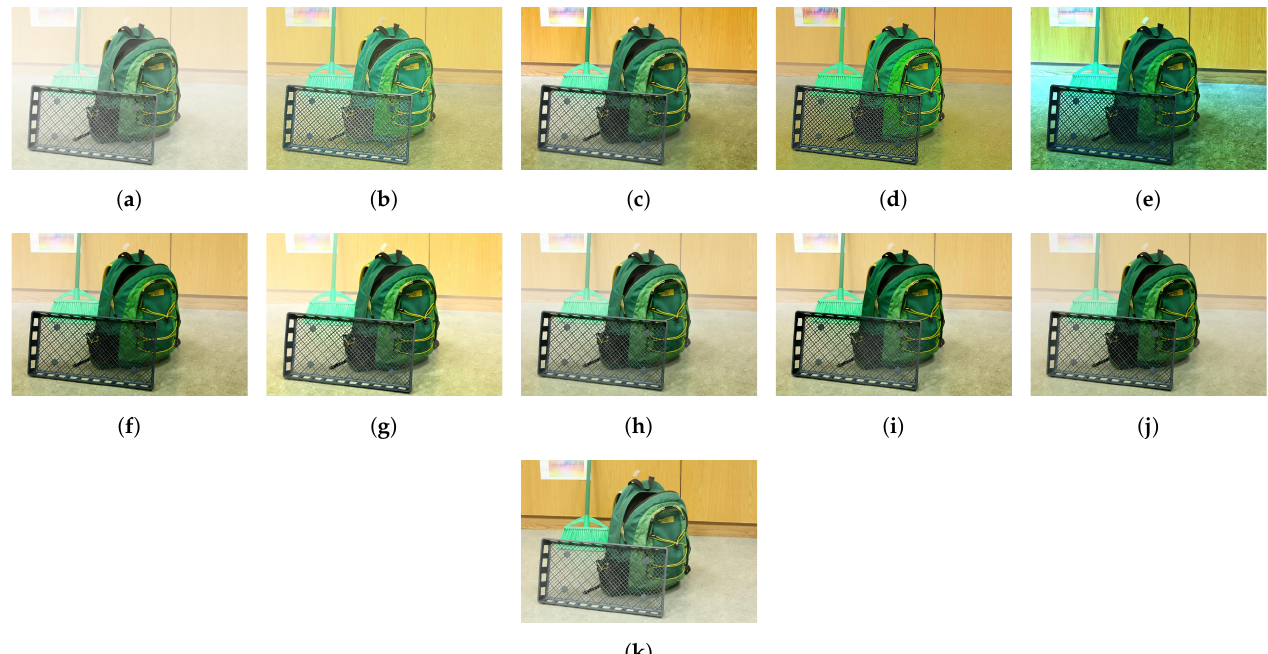
Figure 23. A qualitative comparison of different dehazing methods on a synthetic hazy image of an indoor scene. ( a ) Hazy image, results by ( b ) Tarel and Hautiere [35], ( c ) He et al. [21], ( d ) Kim et al. [36], ( e ) Bui and Kim [50], ( f ) Zhu et al. [52], ( g ) Ngo et al. [74], ( h ) Cai et al. [85], ( i ) Ren et al. [89], ( j ) and the proposed framework, and ( k ) ground